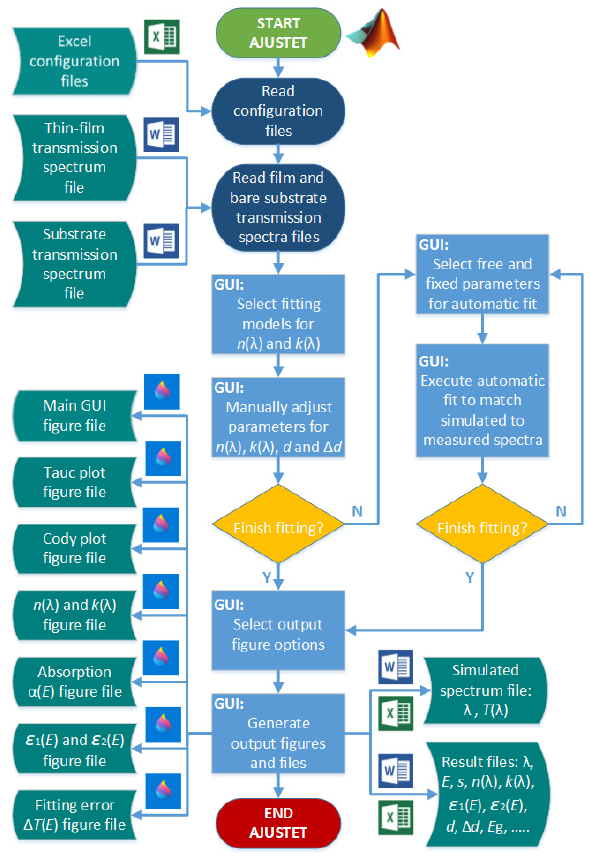
Figure A1. Flowchart for the algorithm corresponding to the MATLAB-based computer program AJUSTET, presented in the present work. It accurately resolves the problem of determining the optical constants, average layer thickness, and wedging parameter of amorphous semiconductor thin films.